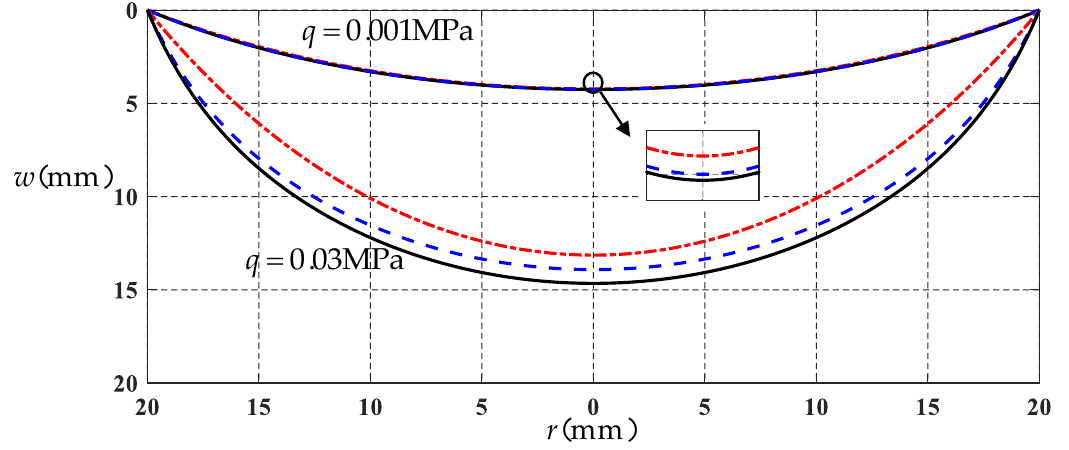
Figure 4. Variation of w with r when q takes 0.001 and 0.03 MPa, respectively.